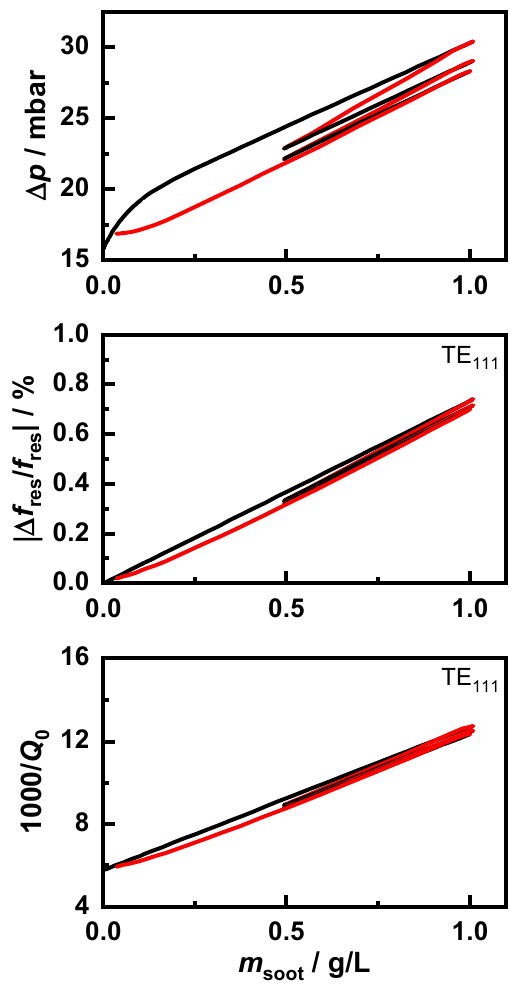
| and / f / f res,0 | and res res res,0